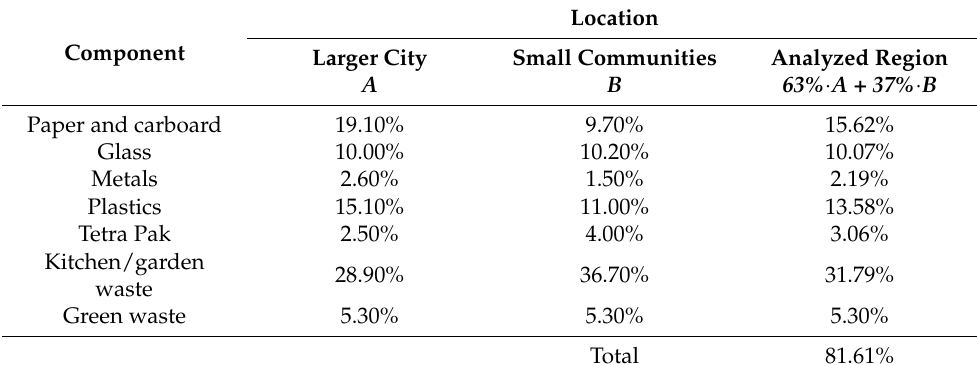
Table 1. Morphological content of recyclable waste in the municipal waste stream generated in the analyzed region.